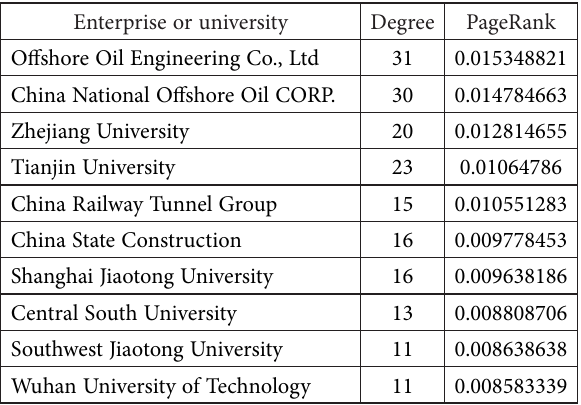
Table 6. Top10 most influential enterprises and universities Enterprise or university